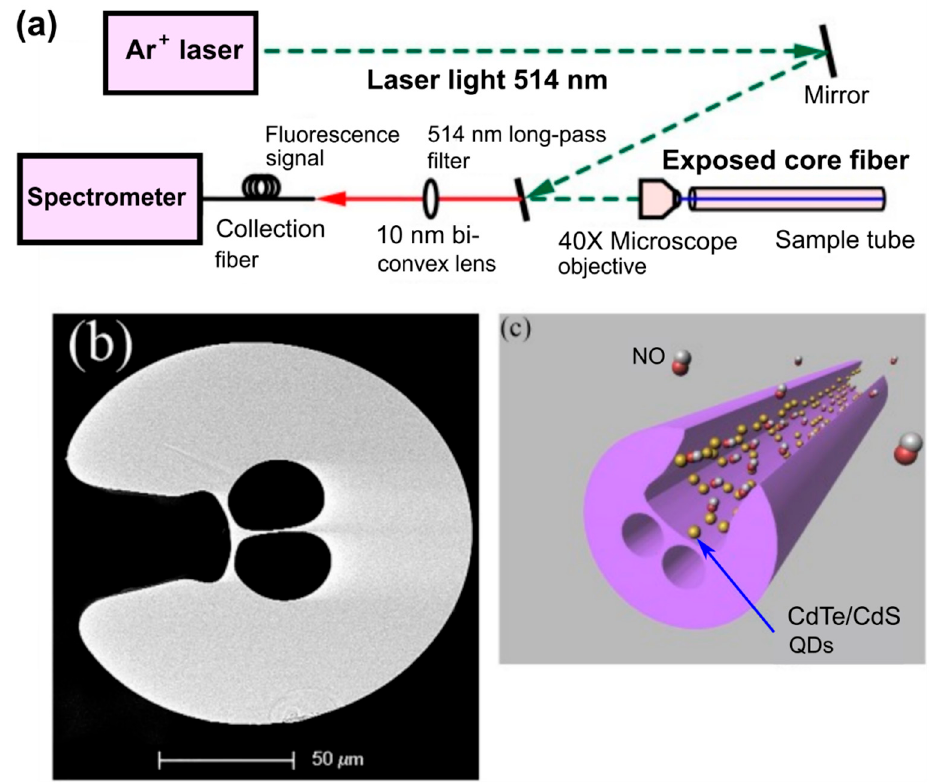
Figure 14. ( a ) Schematic of the experimental setup used for the sensing on the nitric oxide. ( b ) SEM image of the cross-section of the exposed-core MOF sample used in the experiments. ( c ) Illustration of the proposed sensor structure based on functionalized MOF sample. Reproduced with permission from [102].